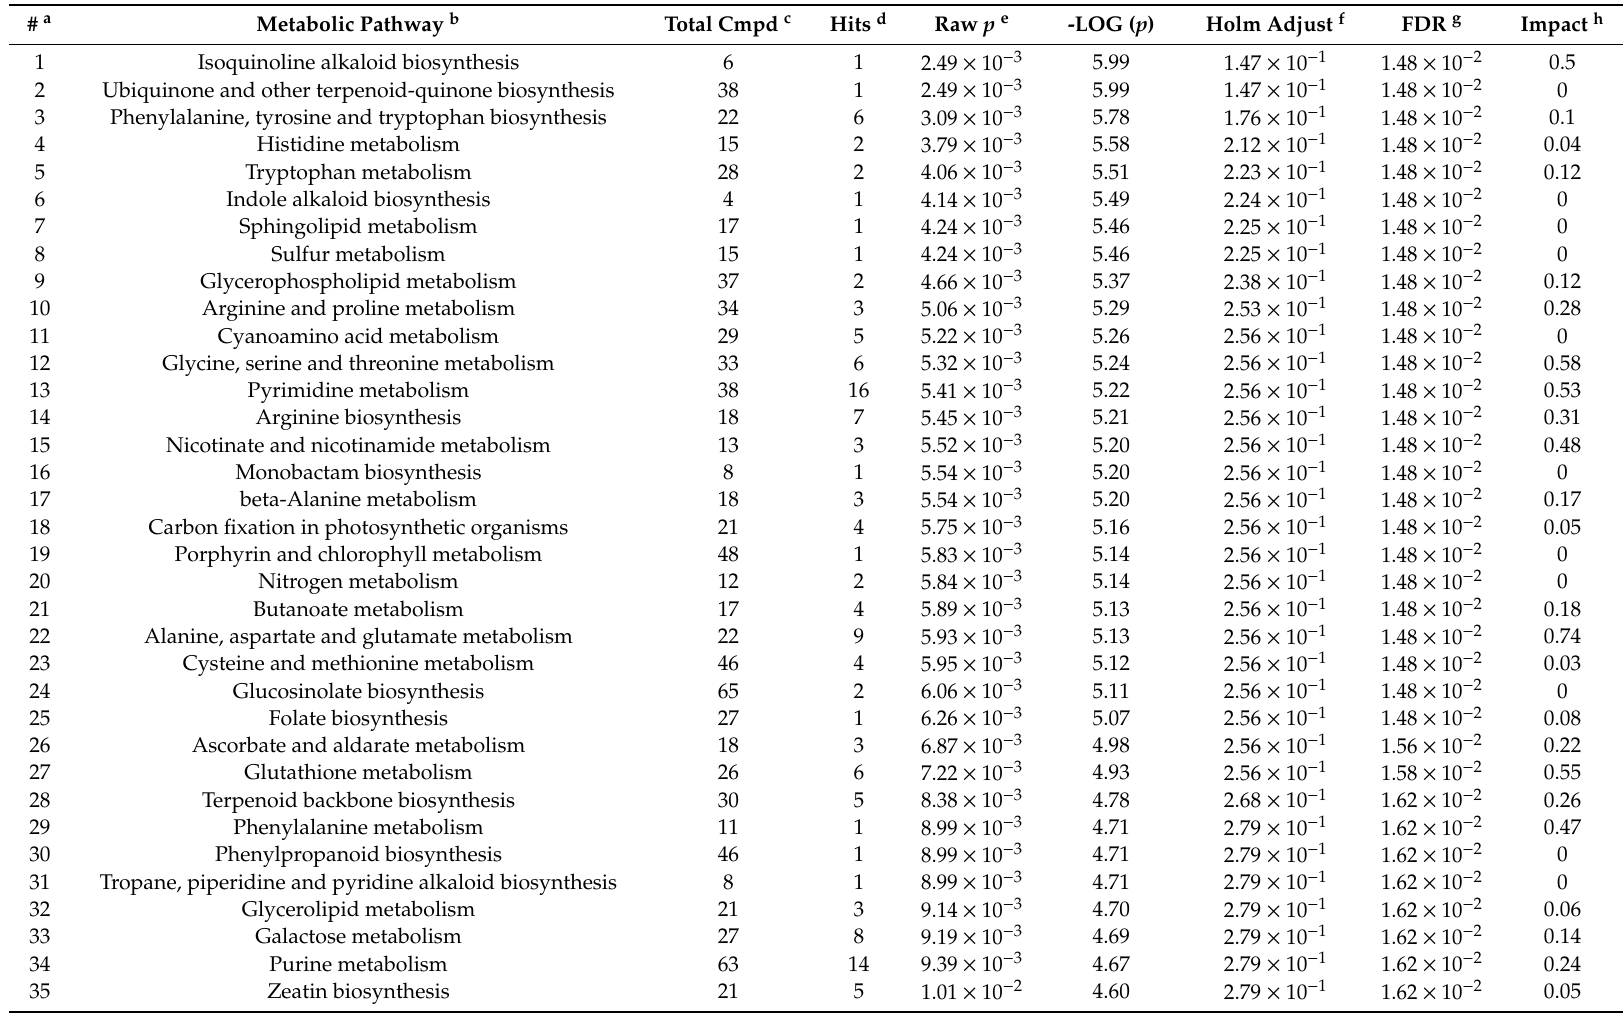
Table 1. Metabolic pathways in mature seeds of pea ( Pisum sativum L.) plants, subjected to short-term drought at the seed filling